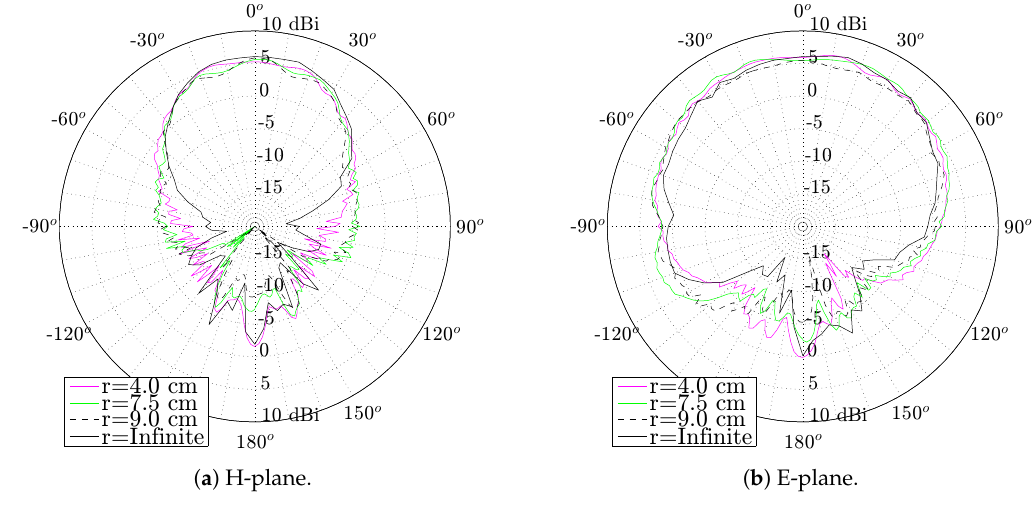
Figure 19. Measured 5.50 GHz free space radiation pattern of the SMA antenna bent around the X-axis, under different curvature radii